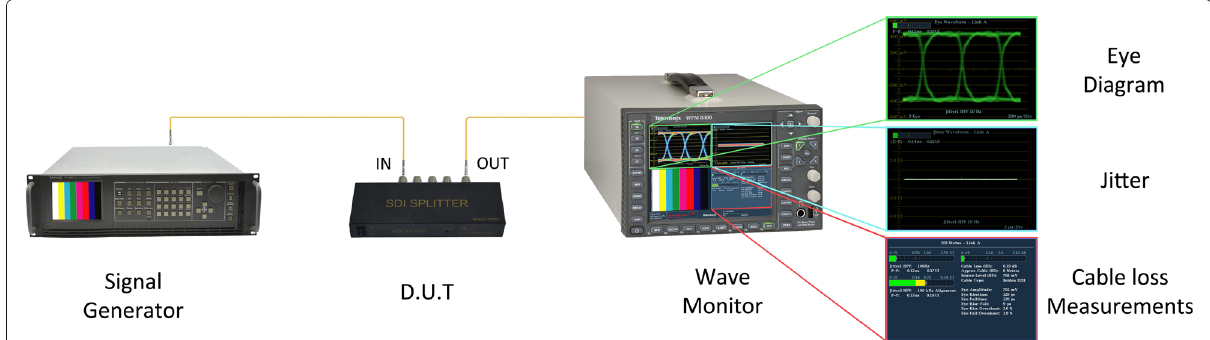
Fig. 1 SDI video equipment connected to the Device Under Test. The right side shows the main testing parameters that can be analyzed using a Hardware Wave